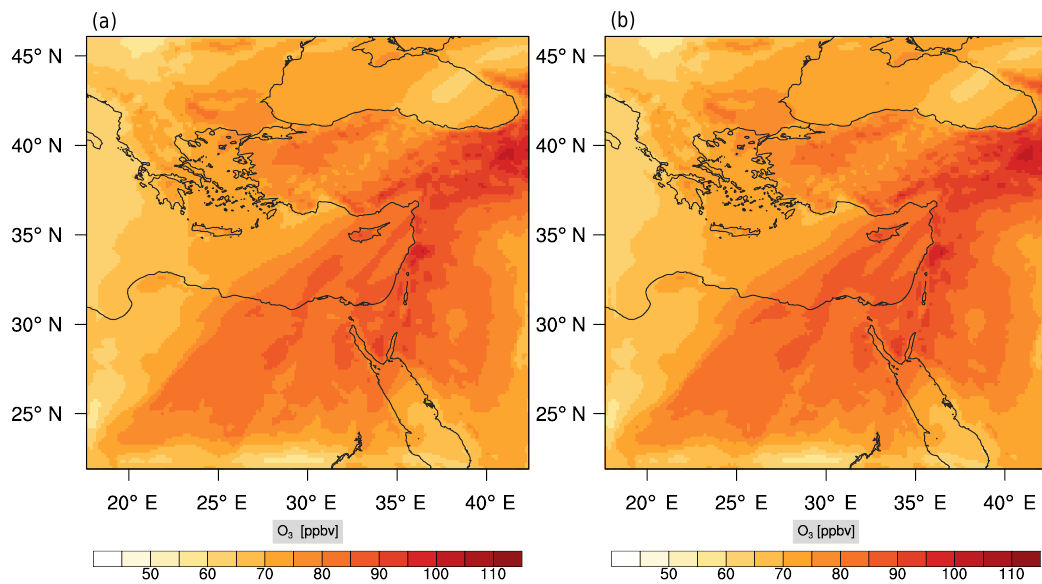
Figure 13. Instantaneous comparison of the ozone spatial mixing ratio, averaged over the vertical layers 10–22, using the full mechanism (a) and the skeletal mechanism (b) .